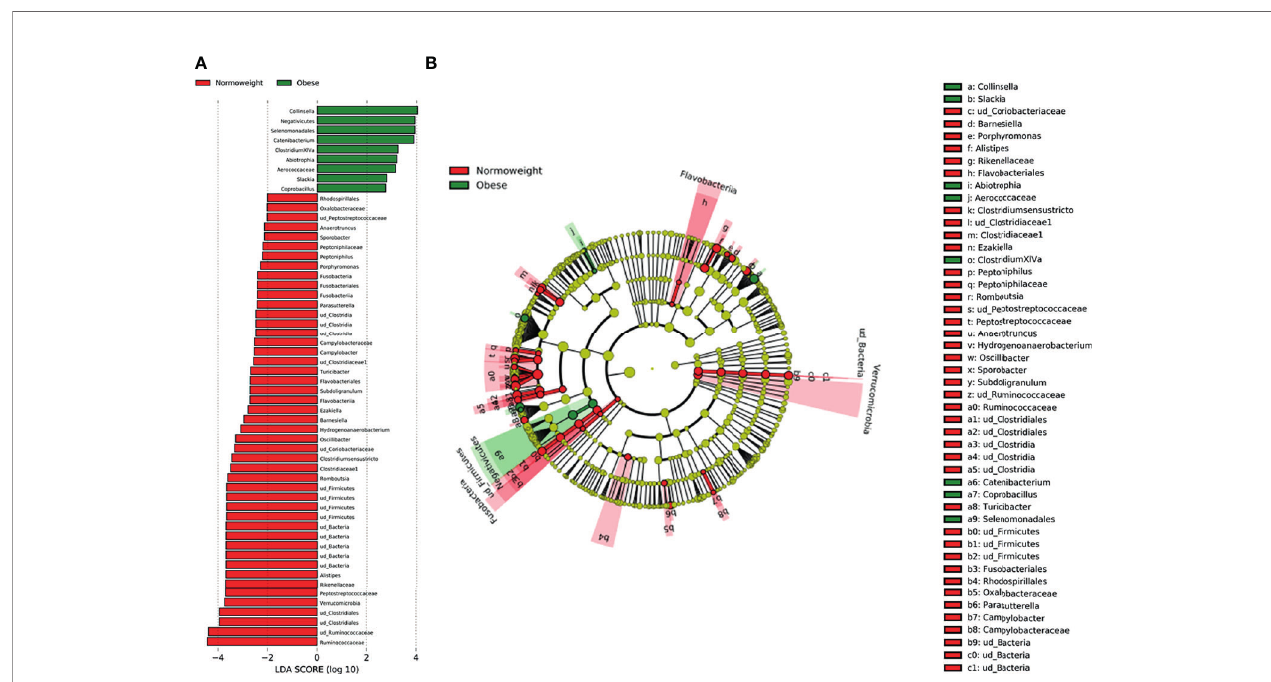
FIGURE 5 | Characterization of microbiomes by LEfSe analysis and LDA. (A) Histogram of the LDA scores (log10) computed for features with differential abundance in normal weight (N) and obese (O) subjects. (B) Cladograms showing the signi fi cant differences of gut microbiota composition in normoweight (N) and obese (O) subjects.